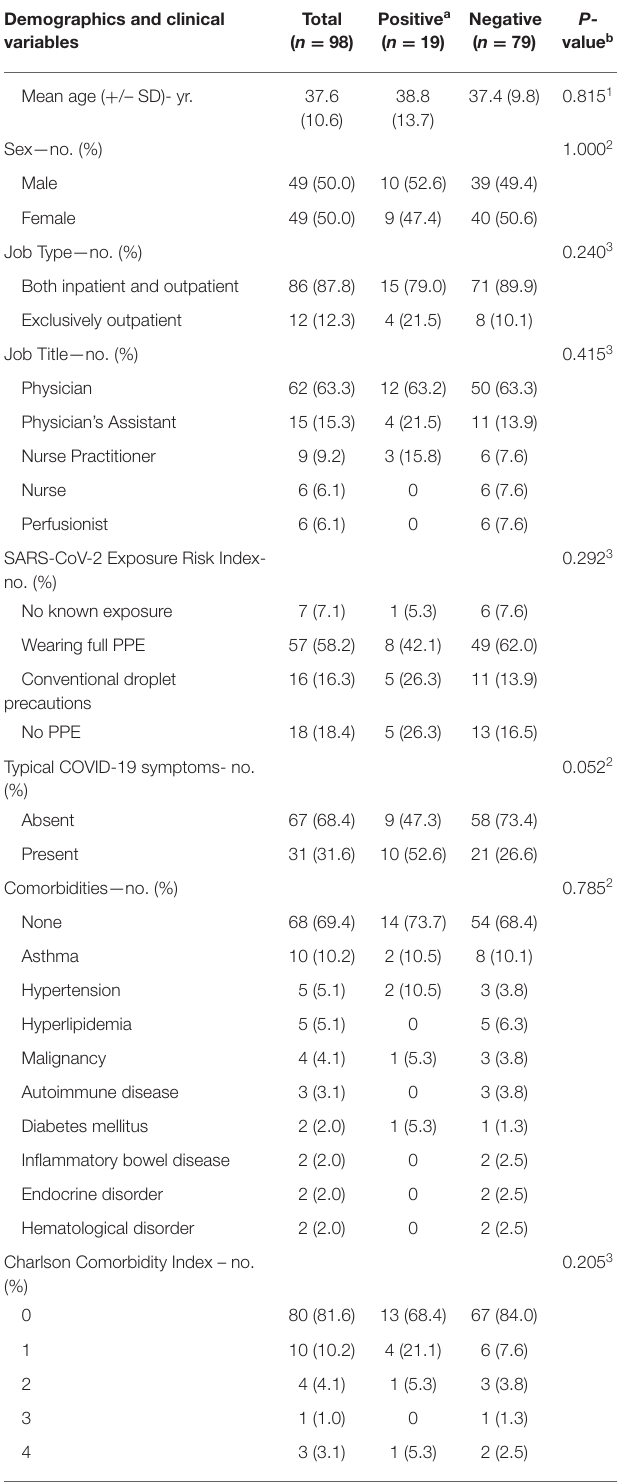
TABLE 1 | Demographics and clinical characteristics of frontline healthcare providers tested for SARS-CoV-2. Demographics and clinical variables